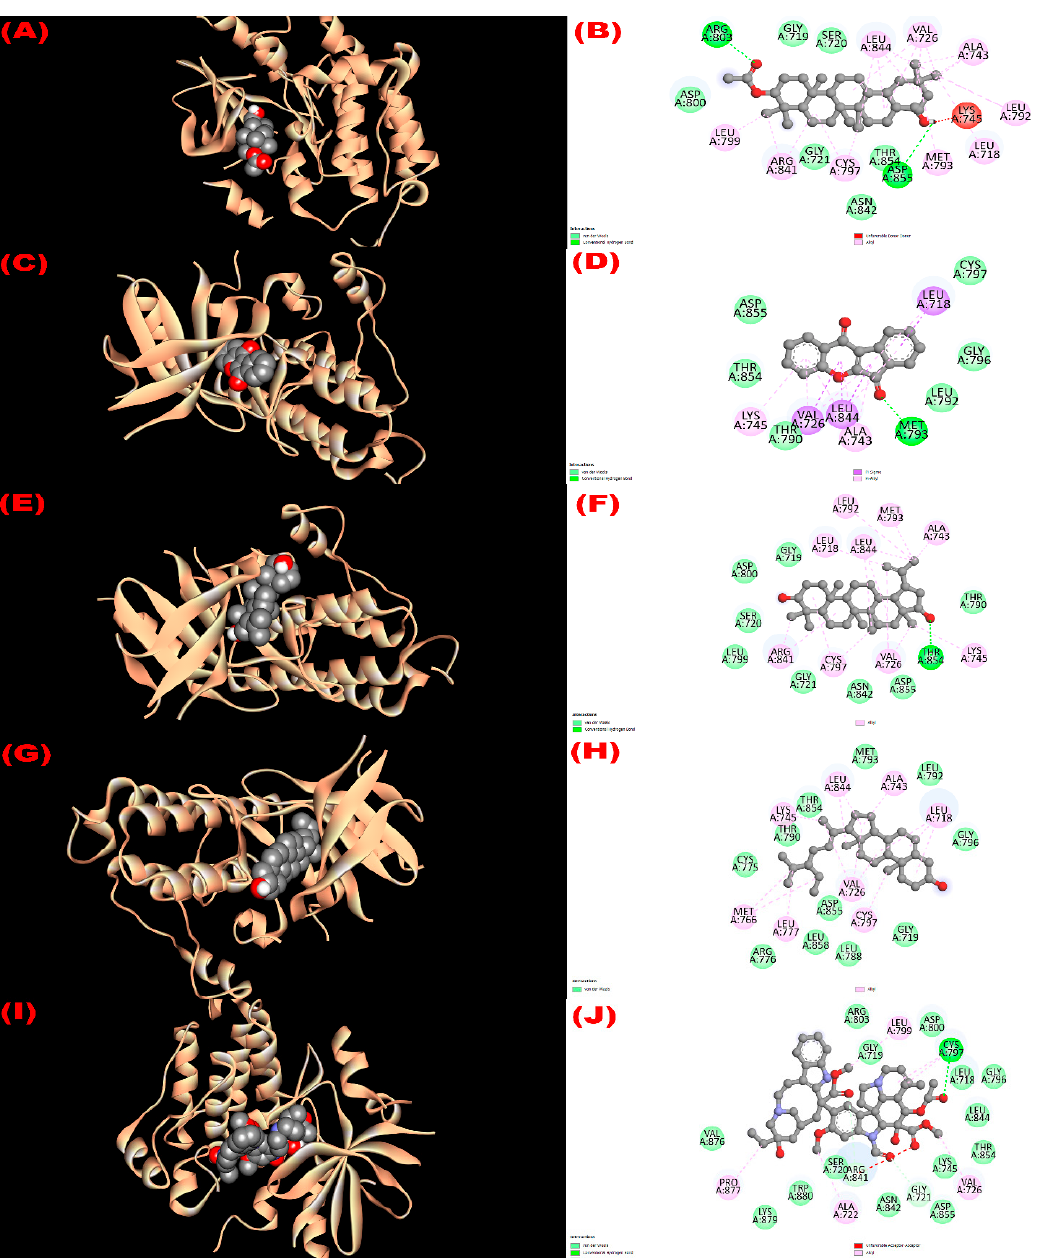
Figure 3. The 3D and 2D view of molecular interactions of the isolated compounds with the epider- mal growth factor receptor (PDB ID: 1XKK) revealing the cytotoxicity. (( A , B ), ( C , D ), ( E , F ), ( G , H ), ( I , J ) sketched the pictorial view of molecular interactions of compounds ( 1 to 4 ) 3 β -acetyloxy-olean-12-en-28-ol, Wrightiadione, 22 β -hydroxylupeol, β -sitosterol, and the standard vincristine, respec- tively).